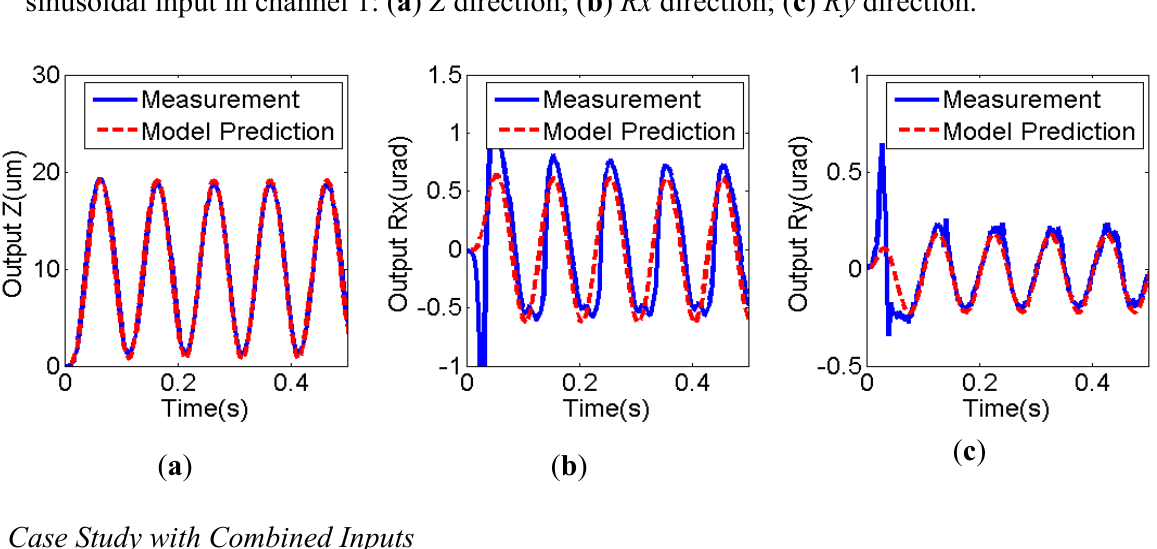
Figure 5. Comparison of experimental results and model prediction under 10 μ m 10